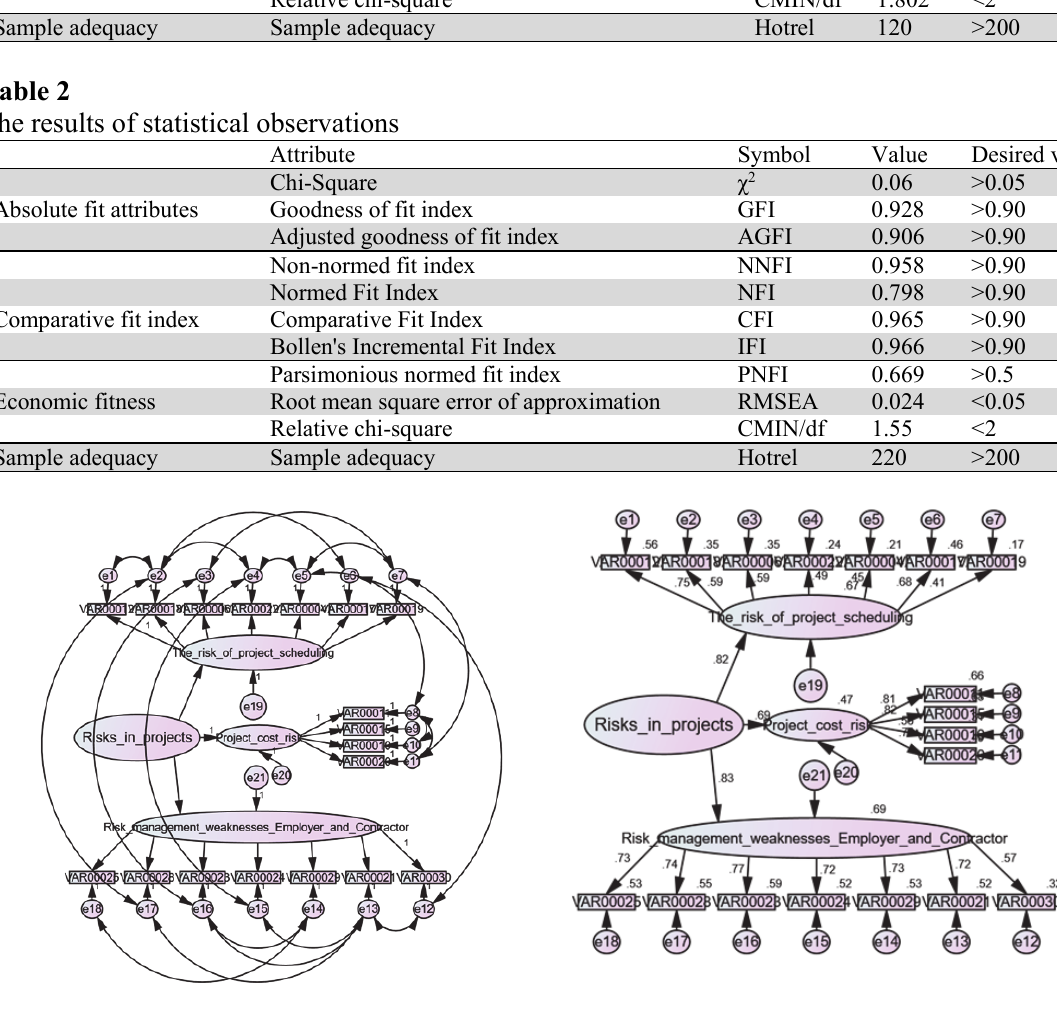
Fig. 4. The revised model Fig. 5. The results of standard